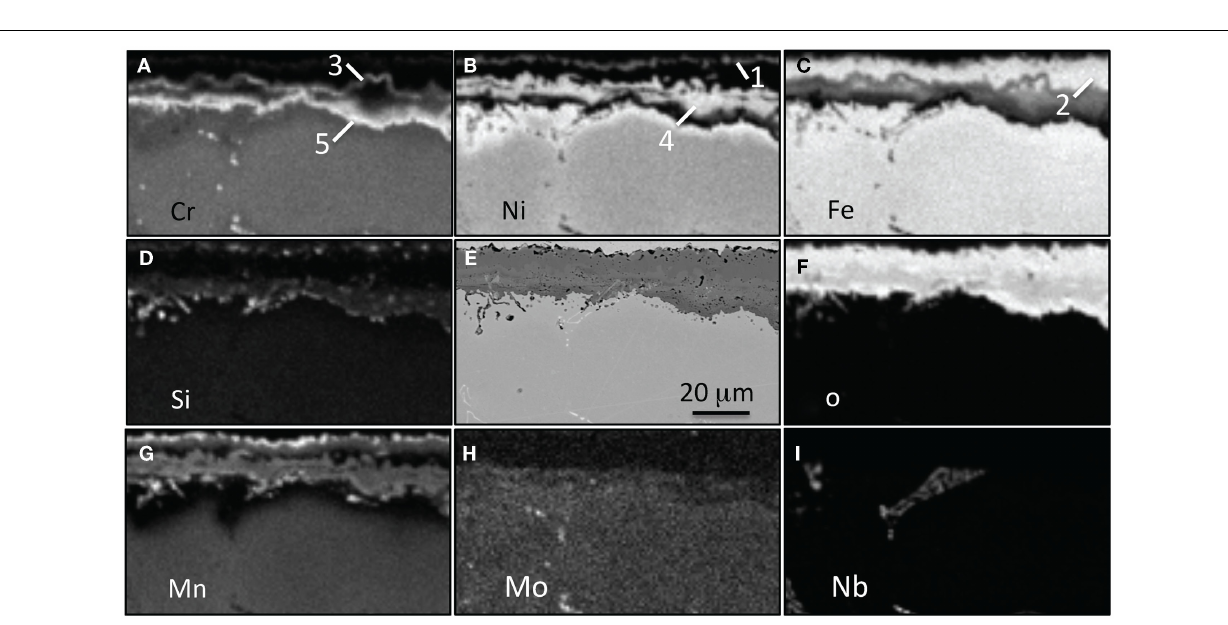
For alloy CF8CP at 750°C and alloys CF8CP and CF8CWCu-1 at 800°C, an inner subscale was observed beneath large oxide nodules ( Figure 12 ). The outer oxide layers rich in Fe and Ni were poorly adherent and spalled frequently during